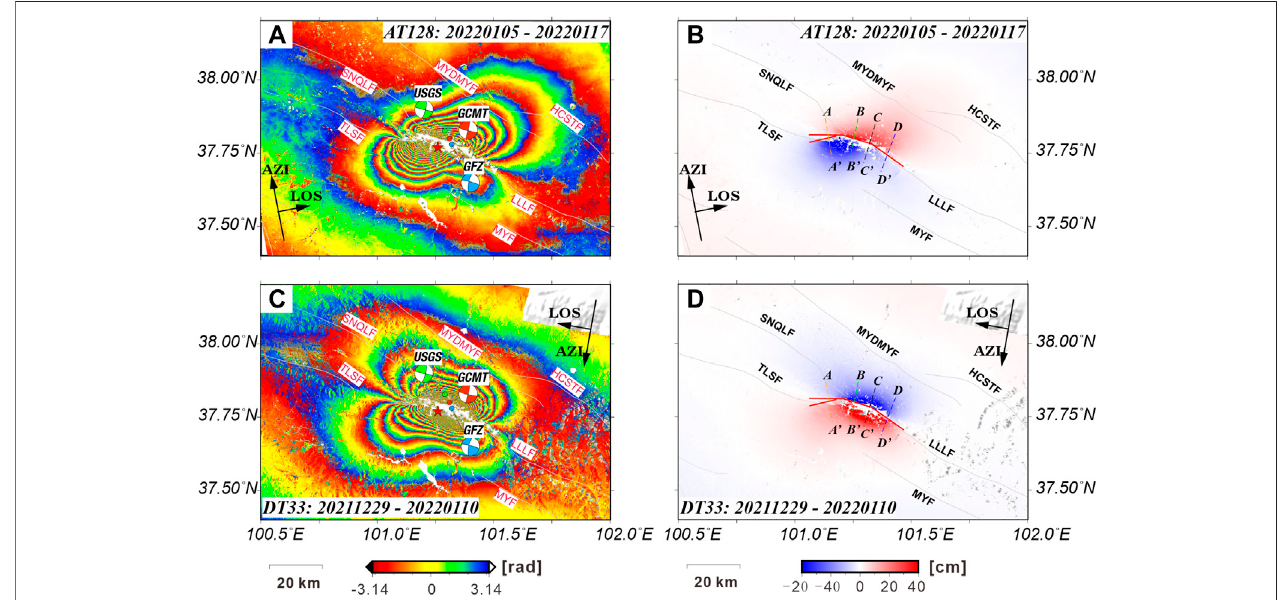
FIGURE 2 | Interferogram and co-seismic deformation fi eld (LOS direction) of Menyuan Ms 6.9 earthquake. (A,C) are the interferograms of T128 ascending orbit and T33descending orbit, respectively.FocalmechanismsolutionsfromGCMT, GFZ,and USGSaredisplayed withthered,blue, and greenfocal spheres.Thered star markstheepicenterofthemainshock. (B,D) aretheLOSco-seismicdeformation fi eldsofT128ascendingorbitandT33descendingorbit,respectively.Thedashedlines labeled by (A – D) are four cross-fault pro fi les shown in Figure 3 , and the red solid lines represent the seismogenic faults. Black arrows indicate satellite fl ight direction (AZI) and right-looking observation direction